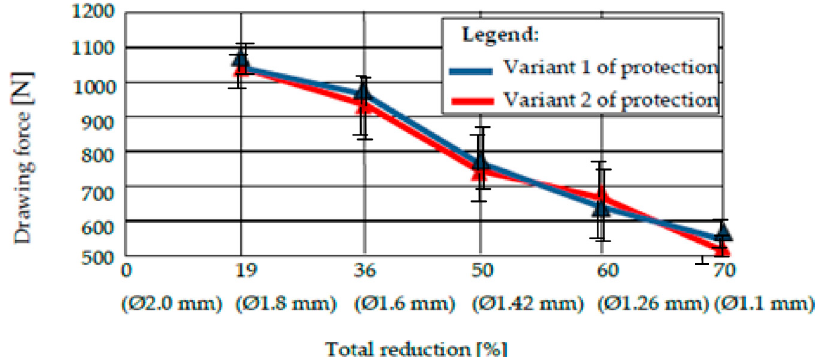
Figure 13. The drawing force of protection variants 1 and 2 for a deformation angle 2· α = 14°.